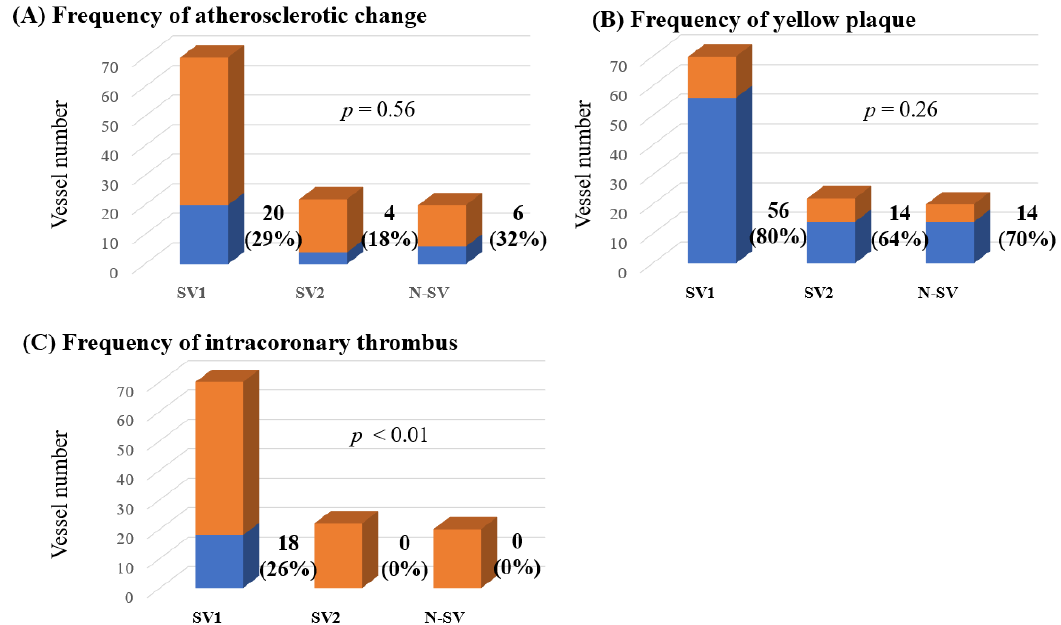
Figure 3. The frequencies of atherosclerotic change ( A ), yellow plaques ( B ) and intracoronary thrombi ( C ) among all lesions observed using CAS. CAS, coronary angioscopy; N-SV, non-spastic vessel; SV, spastic vessel. Among the SVs, those with a visible spastic segment using CAS were defined as SV-1, while those in which the spastic segment was invisible using CAS were defined as SV-2. The frequencies of atherosclerotic change and yellow plaques did not differ significantly between the three groups. However, intracoronary thrombi were detected only in the SV-1 ( p < 0.01). Table 4. Frequencies of atherosclerosis, yellow plaque and intracoronary thrombus in all vessels. Table 5. Frequencies of atherosclerosis, yellow plaque and intracoronary thrombi in 70 spastic vessels.